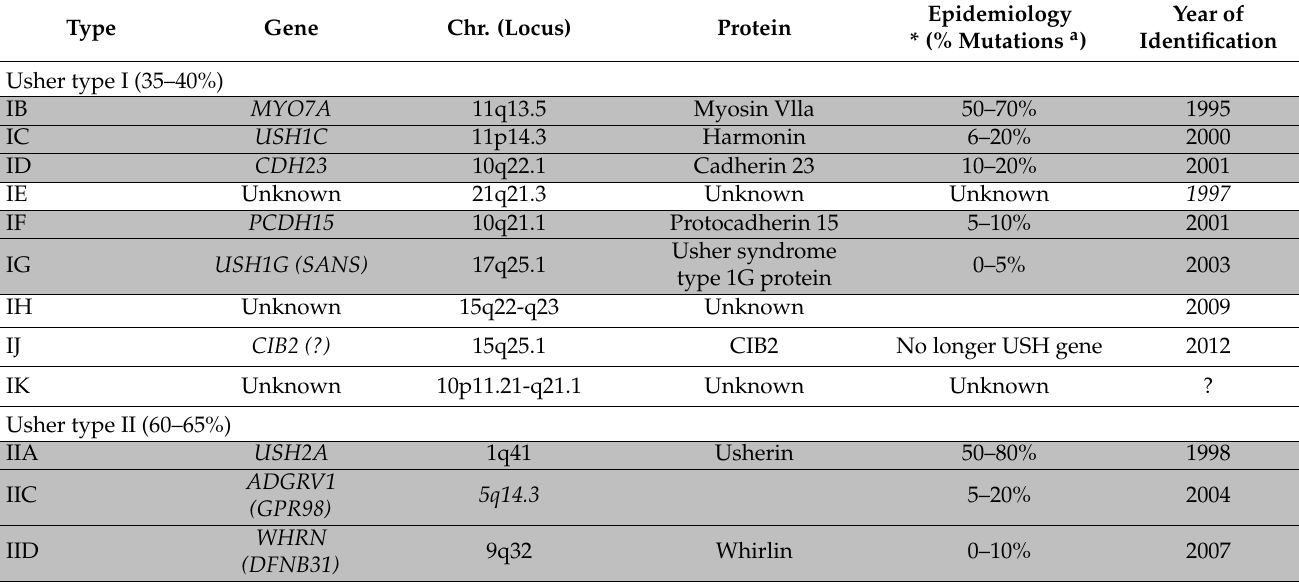
Table 2. Types and subtypes of Usher syndrome and distribution in the general population as estimated * by epidemiological studies. Nine confirmed causative genes are reported in grey. The gene CIB2 has recently been excluded by the extended research of Booth et al. in 2018. There is some evidence that suggest a role of gene HARS in Usher 3B; however, its role must be confirmed in further